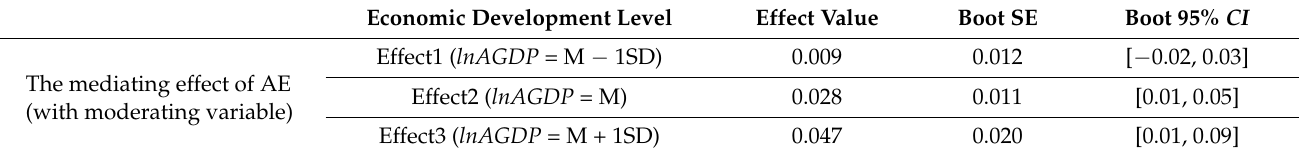
Table 3. Mediating effects at different economic development